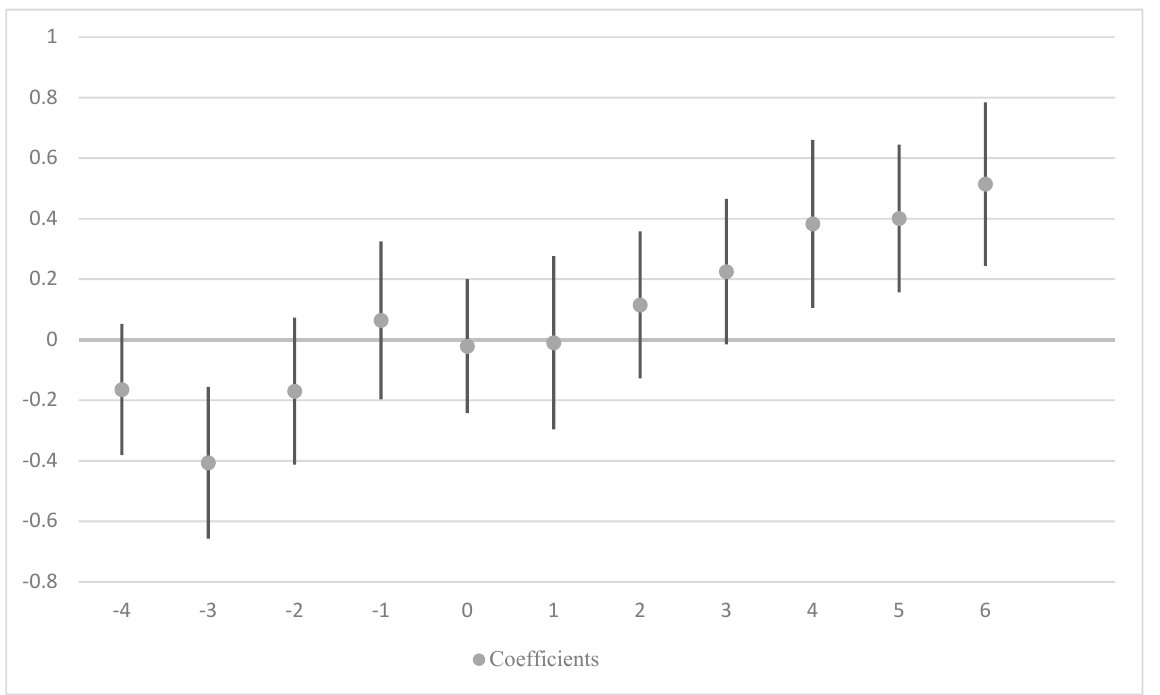
Figure 1. Fluidity surrounding CDS initiation. This figure shows the results of an alternative version of model (1) by replacing Tradedpost with separate dummy variables that indicate the years [ t = − 4 to t = 6] relative to the CDS initiation year (i.e., t = 0). The coefficients and their corresponding 95% con fi dence interval are plo tt ed.